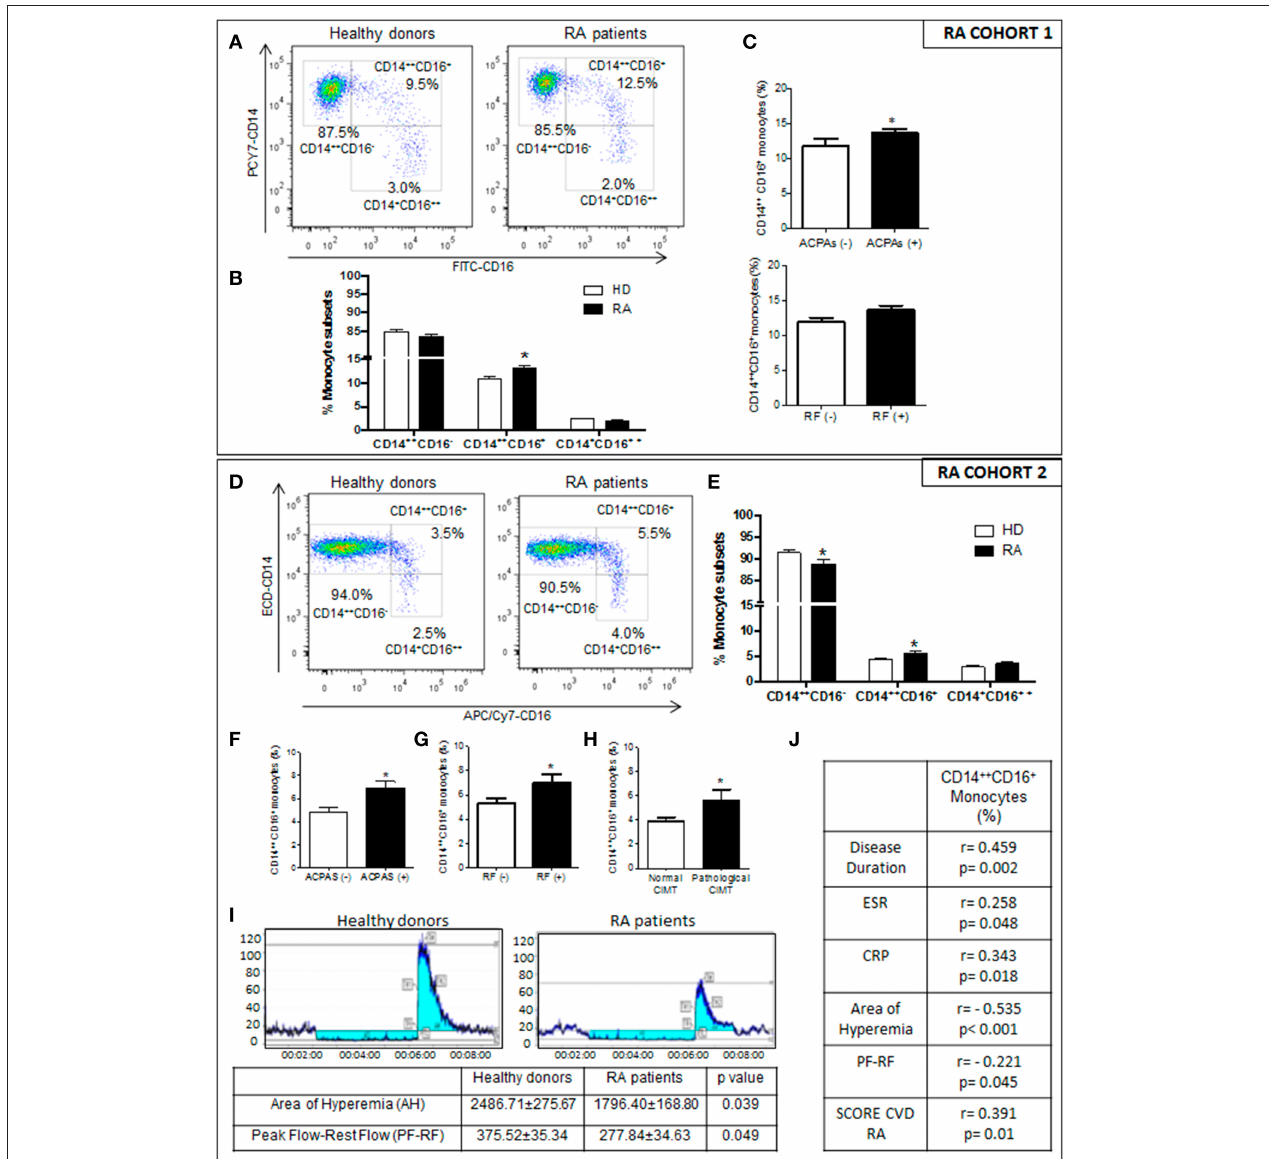
FIGURE 1 | Relationship of the increased intermediate monocyte subpopulation in RA patients with their immunologic and inflammatory profile, and association to endothelial dysfunction, CIMT and CV risk score. (A–C) PRECISESADS Cohort. (A) Representative dot plots of monocyte subtypes from RA patients and HDs. (B) Percentage of different monocyte subtypes by flow cytometry in whole blood of 140 RA patients and 145 HDs. (C) Association between increased frequency of intermediate monocytes and autoimmunity. (D–J) Second cohort: 50 RA patients and 33 HDs. (D) Representative dot plots of monocyte subtypes from RA patients and HDs. (E) Percentage of different monocyte subtypes by flow cytometry. (F–H) Association between increased frequency of intermediate monocytes with autoimmunity and pathological CIMT. (I) Impaired microvascular endothelial dysfunction in RA patients measured by Laser-Doppler. (J) Correlations between the percentage of intermediate monocytes and clinical parameters of the disease, endothelial dysfunction and SCORE CVD. Paired t -test was performed *indicates significant differences vs. HDs ( p < 0.05).